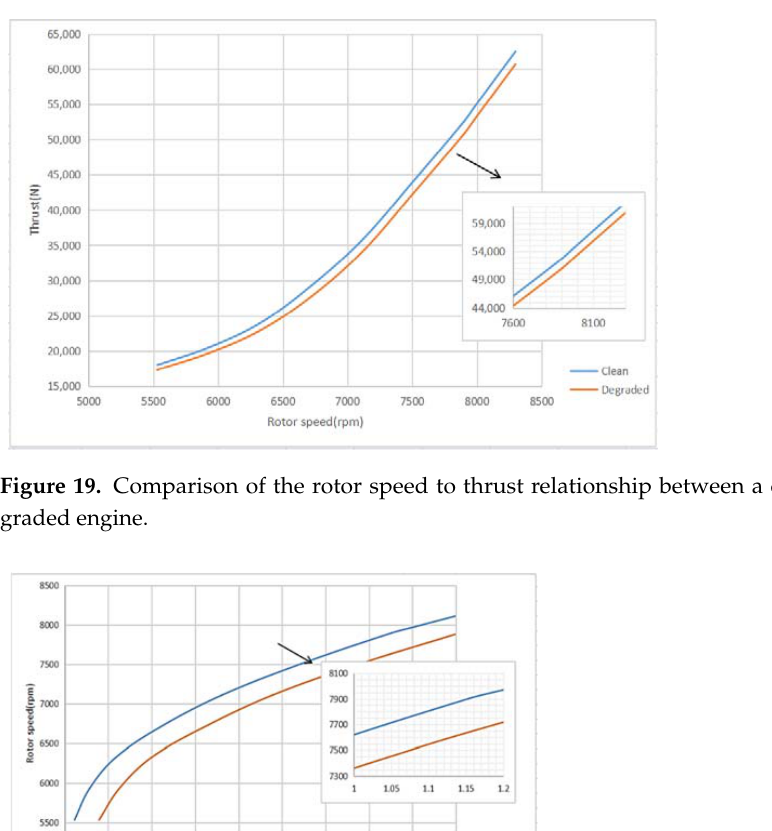
Figure 21. Comparison of the fuel flow to turbine temperature relationship between a clean engine and degraded engine. Figure 22. Comparison of the thrust to turbine temperature relationship between a clean engine and degraded engine. The effects of degradation on relationships of performance parameters are summa ‐ rized in Table 4. The degradation affects all engine control modes, including steady ‐ state, transient, and physical limitations. Thus, these effects should be managed to compensate for the capability of the engine in providing the required thrust (steady ‐ state mode) in an acceptable response time (transient mode) without violating the physical limitations. This management strategy will be developed in the next section.